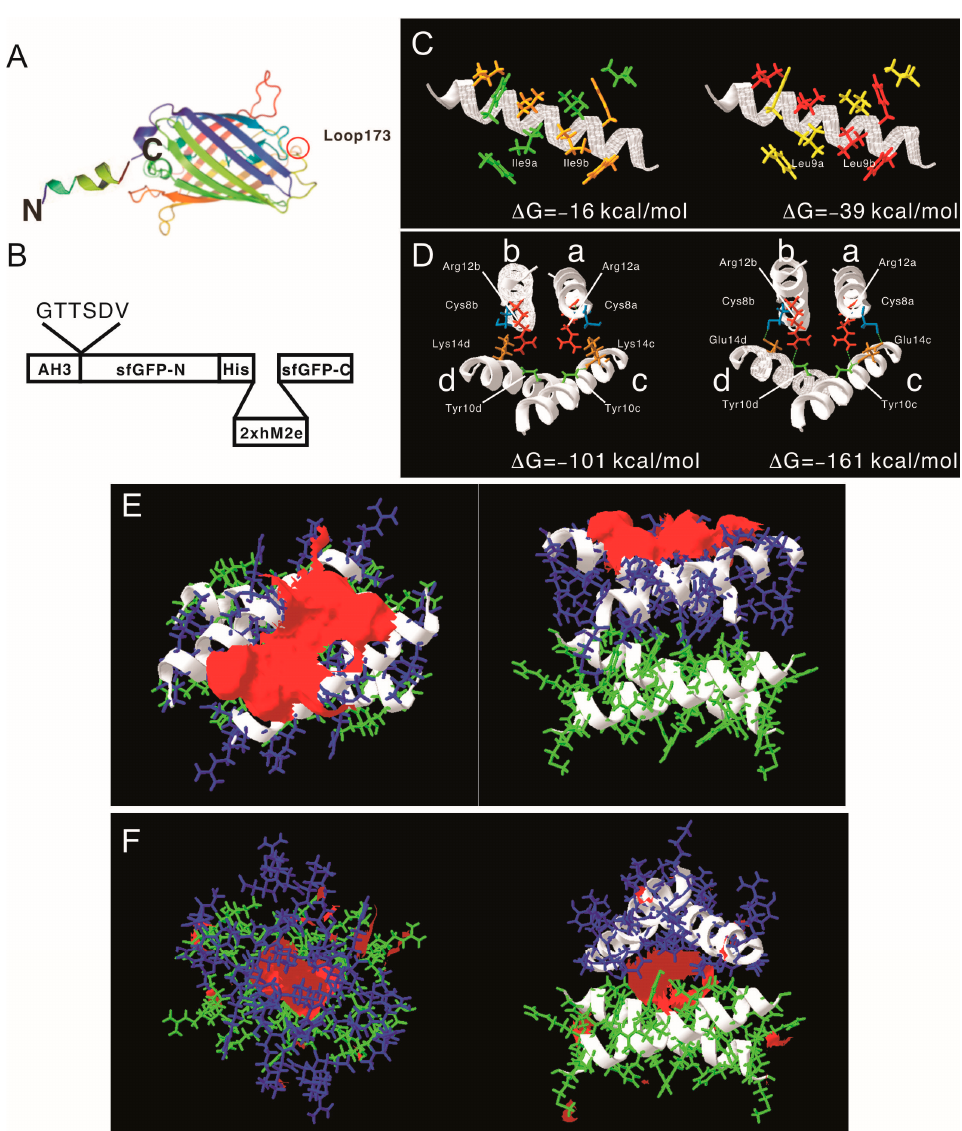
Figure 3. Construction of AH3–sfGFP–2xhM2e fusion protein and the protein model guided AH3 mutagenesis for variants with a higher nanoparticle stability. ( A ) The graphic presentation of the AH3–sfGFP fusion protein is shown and the antigen insertion site (loop173) is marked by a red circle. The AH3 peptide was fused to the N-terminal of sfGFP to mediate polymerization and a foreign antigen insertion site is genetically created in loop173 containing an 8xHis tag for efficient protein purification. The N-terminal and C-terminal of the fusion protein is marked by N and C respectively. ( B ) The graphic presentation of AH3–sfGFP–2xhM2e fusion protein is shown. ( C ) The comparison of AH3 and AH3 I9L (LY) mutant in dimer formation is shown. The calculated intermolecular force between two monomers are shown. ( D ) The hydrogen bonds that formed between AH3 variant LYRRLE dimers are shown in the right panel. AH3 tandem tetramer is shown in the left panel. Four monomers from each model are labeled from a to d. The Glu14 from monomers c and d form hydrogen bonds with Cys8 from monomers a and b respectively. Additionally, the side chain of Arg12 from monomers a and b forms a hydrogen bond with the backbone of monomers c and d, respectively. ( E ) The front view (left panel) and bottom view (right panel) of the LYRRLE tandem tetramer protein models. ( F ) The front view (left panel) and bottom view (right panel) of the LYRRLE inverted tetramer. The hydrophobic patch is marked as red surface, the first dimer is colored as green, and the second dimer is colored as blue. The calculated intermolecular interaction force is shown in the center of both